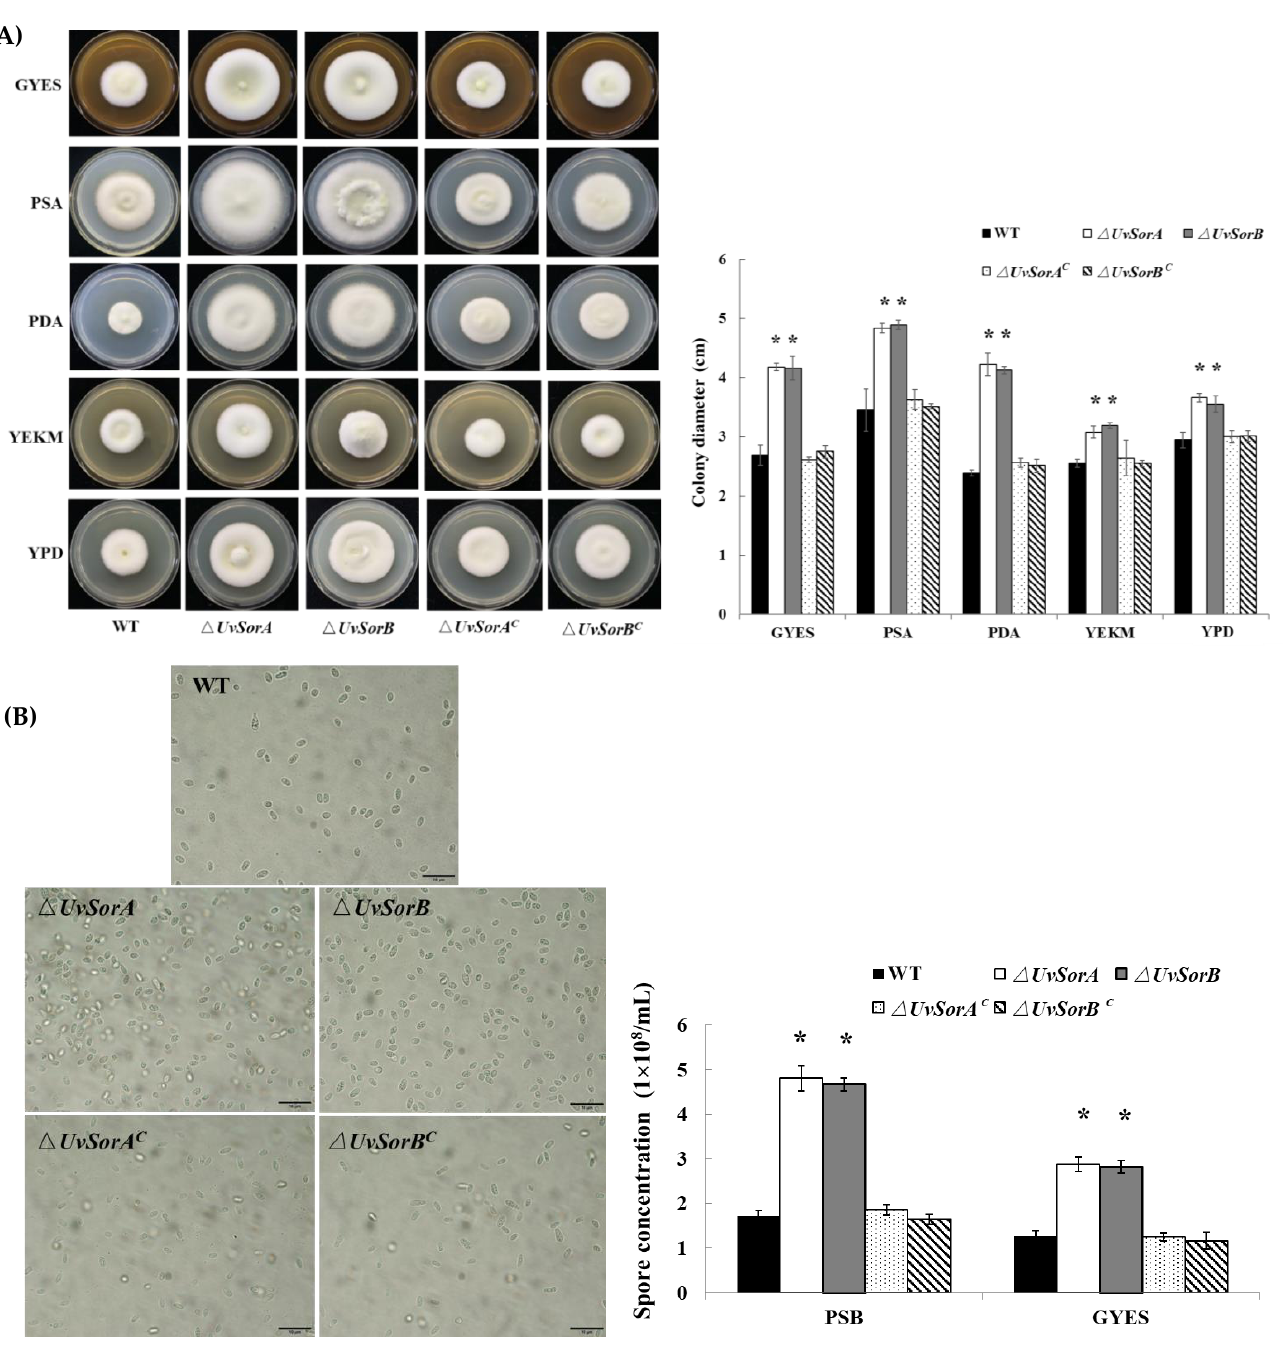
Figure 6. UvSorA and UvSorB disruption resulted in an increased mycelial growth and sporulation. ( A ) Mycelia growth of the tested strains cultured at 28 °C for 18 days on different media (left panel). Statistical analysis of the colony diameters (right panel); ( B ) Microscope detection of the spores collected from the tested strains cultured in PSB medium at 28 °C with 160 rpm for 7 days. Scale bar = 20 μm (left panel). Statistical analysis of spore concentrations in PSB medium and GYES medium (right panel). Three independent biological experiments were performed with three replicates each time, with similar results yielded in each biological experiment; Error bars represent the standard deviation, and asterisk (*) represents a significant difference at p < 0.05.